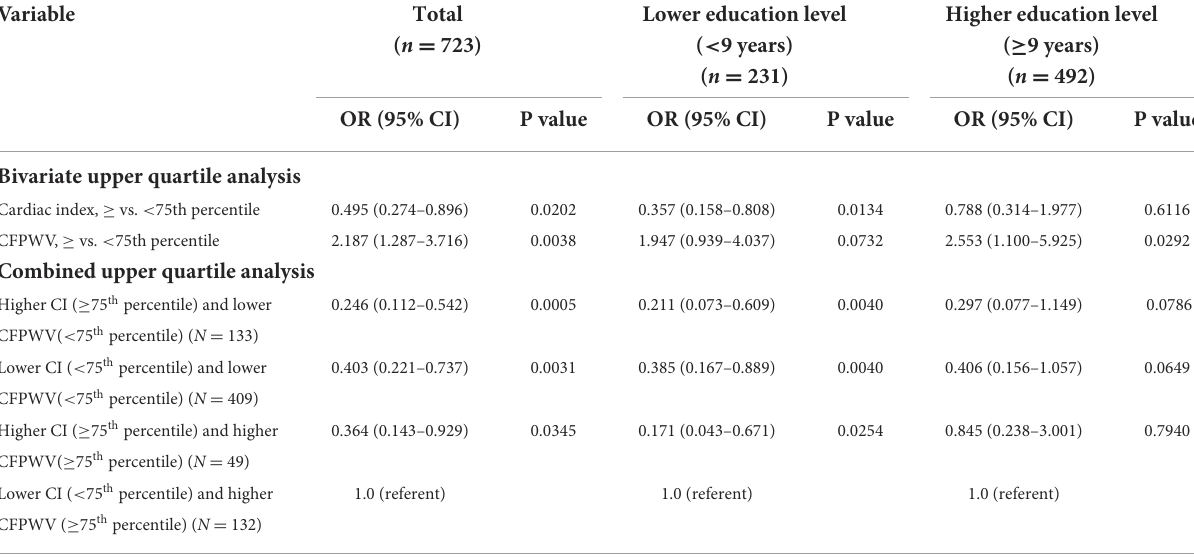
TABLE 3 Association between low MMSE and cardiac index, carotid-femoral pulse wave velocity and education years, multivariable logistic analyses stratified by levels of education. Variable